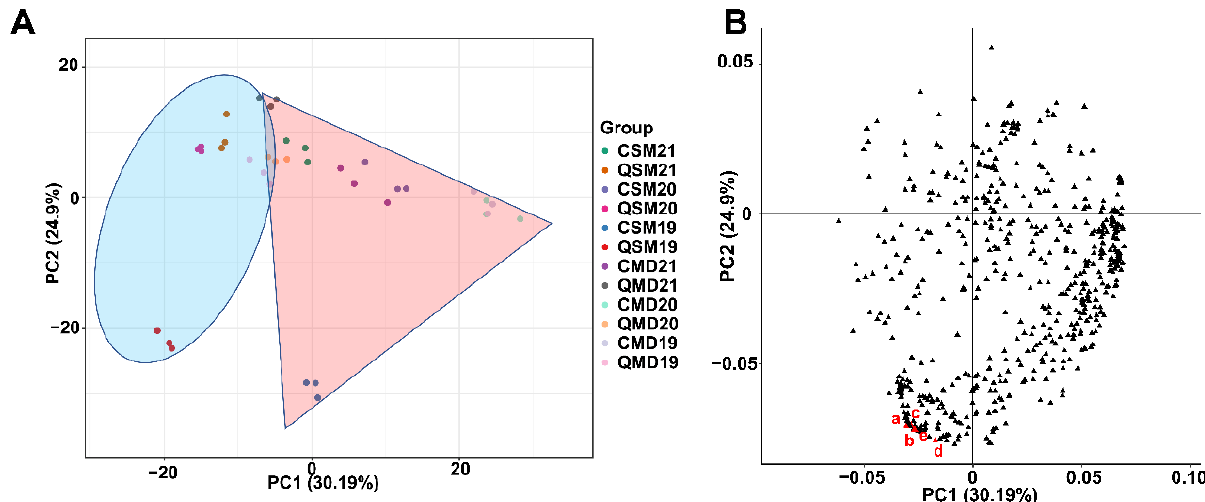
Figure 5. ( A ) PCA of VOCs in SPWTs and APWTs; and ( B ) PCA loading score plots. The points falling in the shaded area of the red triangle are SPWTs and in the shaded area of the blue oval are APWTs. In Figure 5B, triangles indicate all detected VOCs, with the top five VOCs contributing most to the difference between groups marked in red and the others in black. White teas picked in spring were called SPWTs and those picked in autumn were called APWTs. White peony teas and Shou Mei picked in spring were termed CMD19-21 and CSM19-21, respectively, while those picked in autumn were correspondingly named QMD19-21 and QSM19-21. The number following CMD, QMD, CSM, and QSM represented the production years, corresponding to 2019, 2020, and 2021, respectively (Table